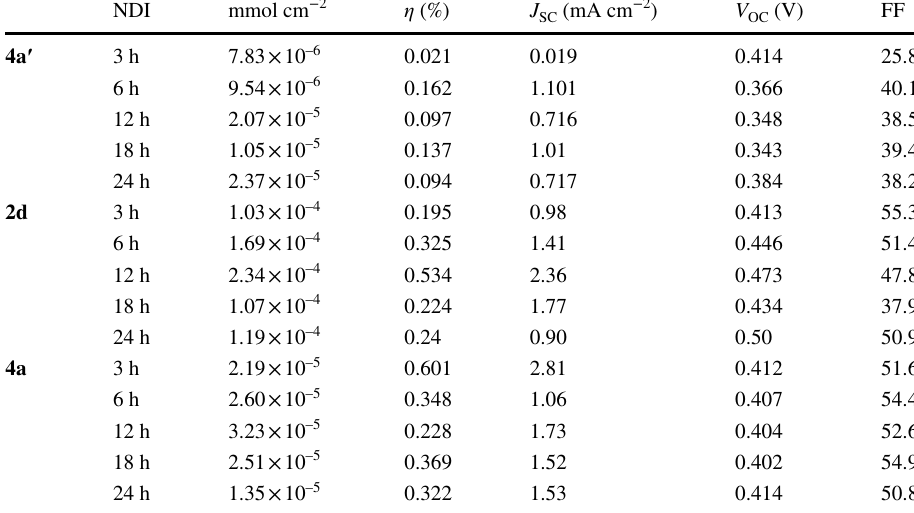
Table 3 Study of the effect of sensitization time, concentration and efficiency of NDI